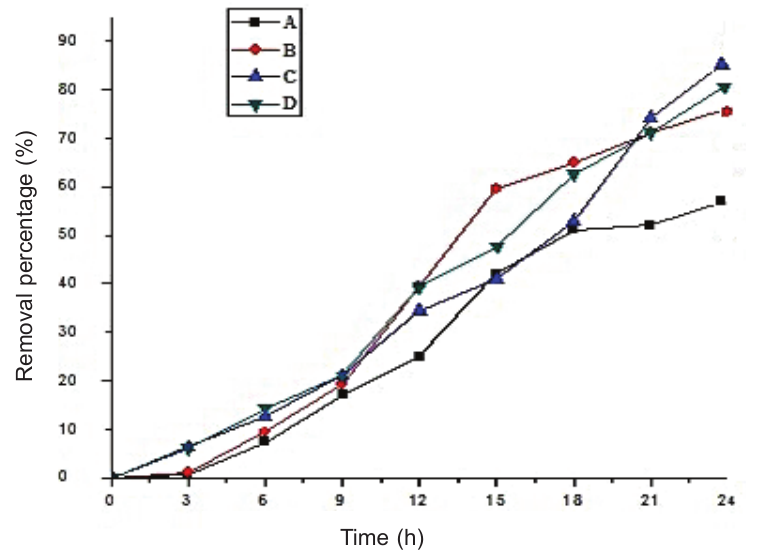
Fig. 3 – Effect of temperature on the phenol degradation of strain N8 (A 20 °C; B 25 °C; C 30 °C; D 35 °C)